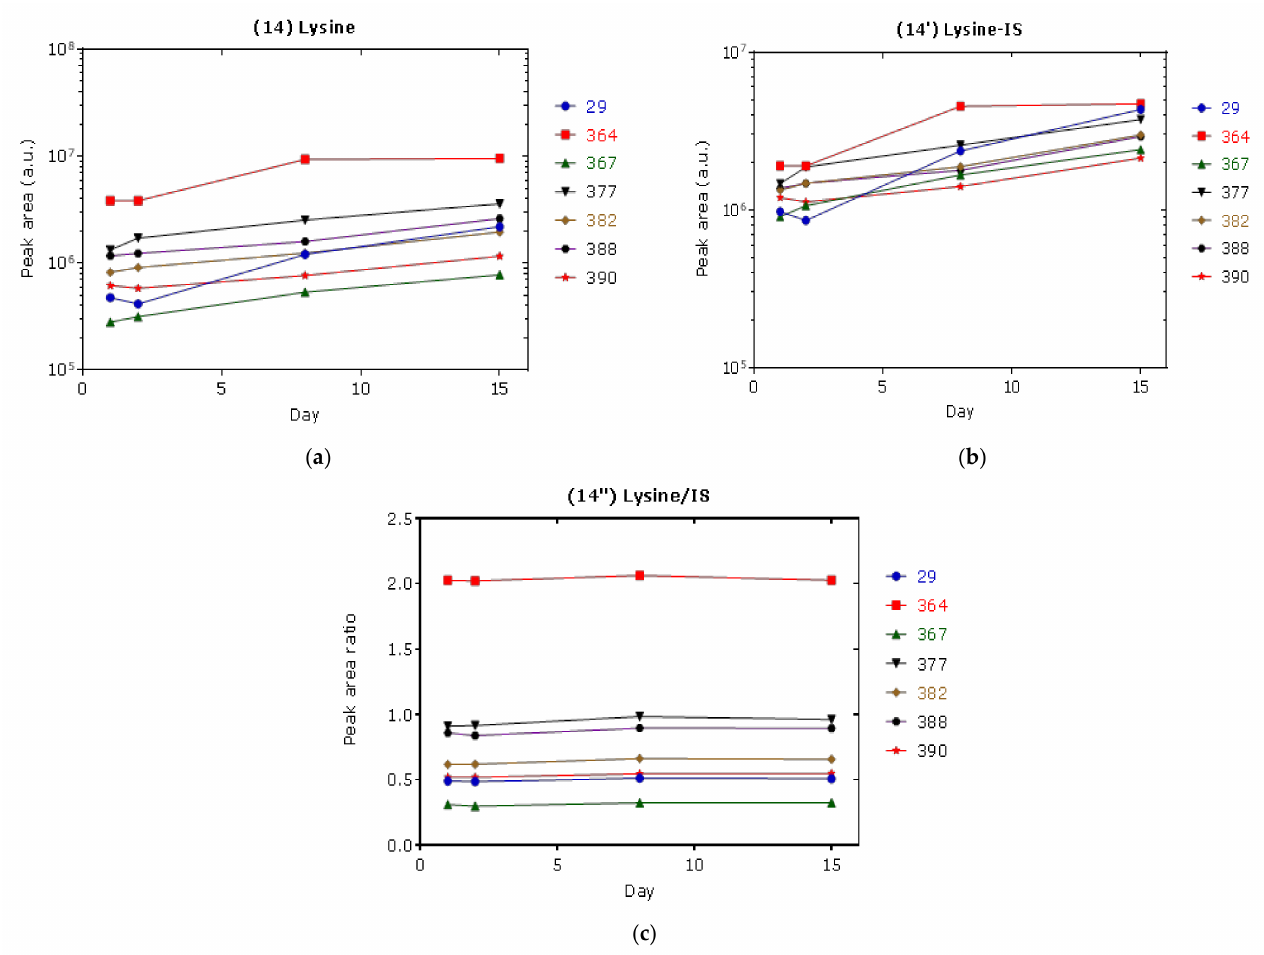
Figure 1. ( a ) Plots of the peak area of urinary lysine (upper left panel), ( b ) of the peak area of its internal standard (upper right panel), and ( c ) of the peak area ratio of lysine to its internal standard (lower panel) in seven 24 h collected urine samples against the storage time of the toluene extracts (day 1, 2, 8, 15). Note the decadic logarithm scale on the y axes in the left and middle panels. The plots of the other amino acids investigated in this study are found in the Supplementary Information. IS, internal standard; a.u., arbitrary